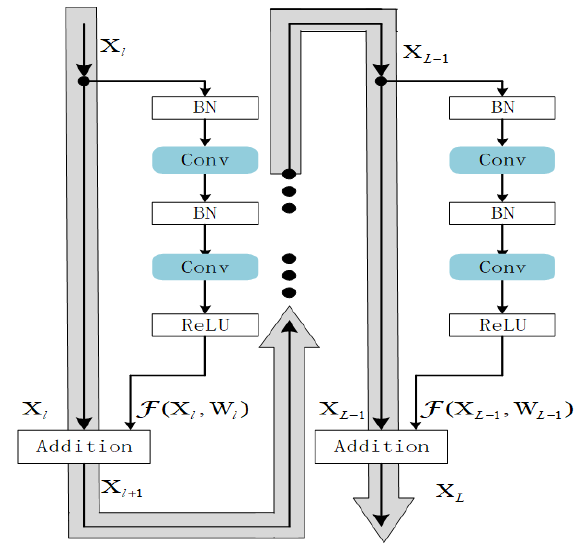
Figure 7. Structure of Residual Network.